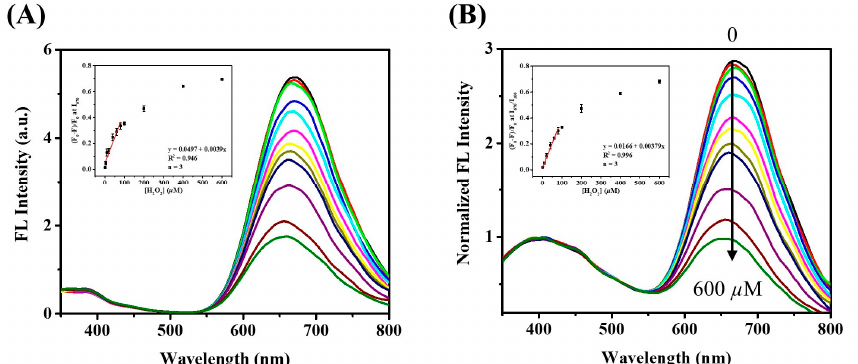
Figure 3. Fluorescence emission spectra of ( A ) GSH/BSA-AuNCs and ( B ) GSH/BSA-AuNCs@VCDs in aqueous solution upon addition of various concentrations of H 2 O 2 (from top to bottom: 0, 1, 4, 10, 20, 40, 60, 80, 100, 200, 400, 600 μ M), excitation at 320 nm. Insert: Stern–Volmer plot.